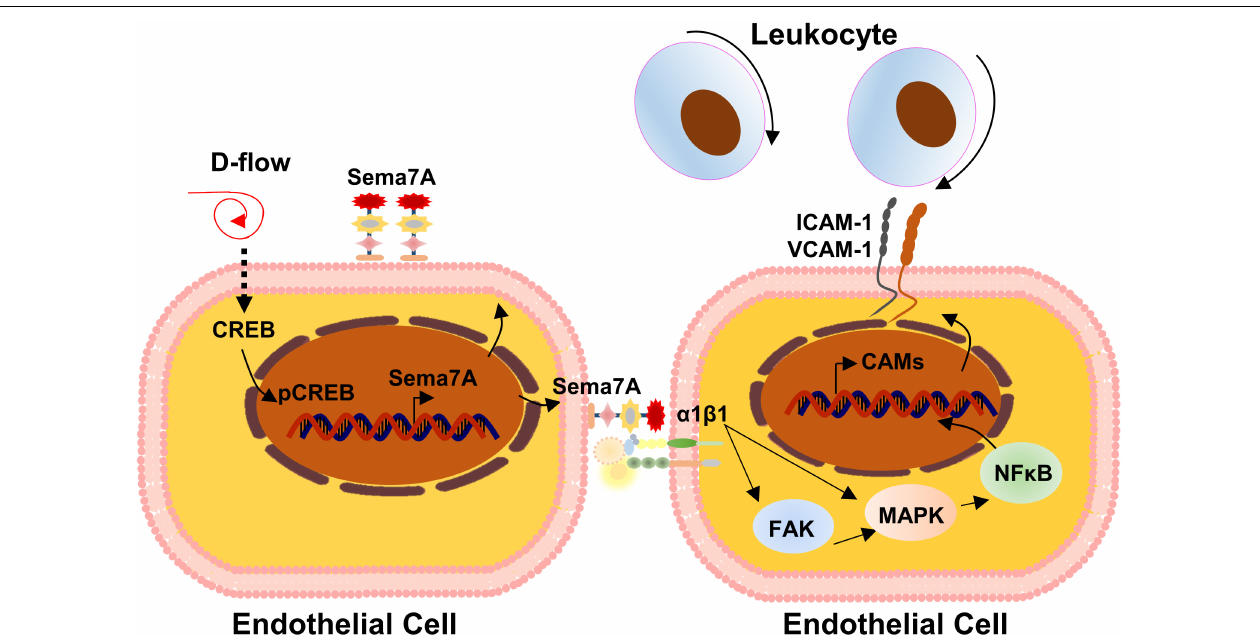
FIGURE 5 | Mechanistic diagram of Sema7A in atherosclerosis. Endothelial Sema7A is upregulated in response to d-flow in the lesser curvature of mouse aortic arch, which is potentially regulated by the inhibition of cAMP response element-binding protein (CREB) signaling. Sema7A promotes the expression of adhesion